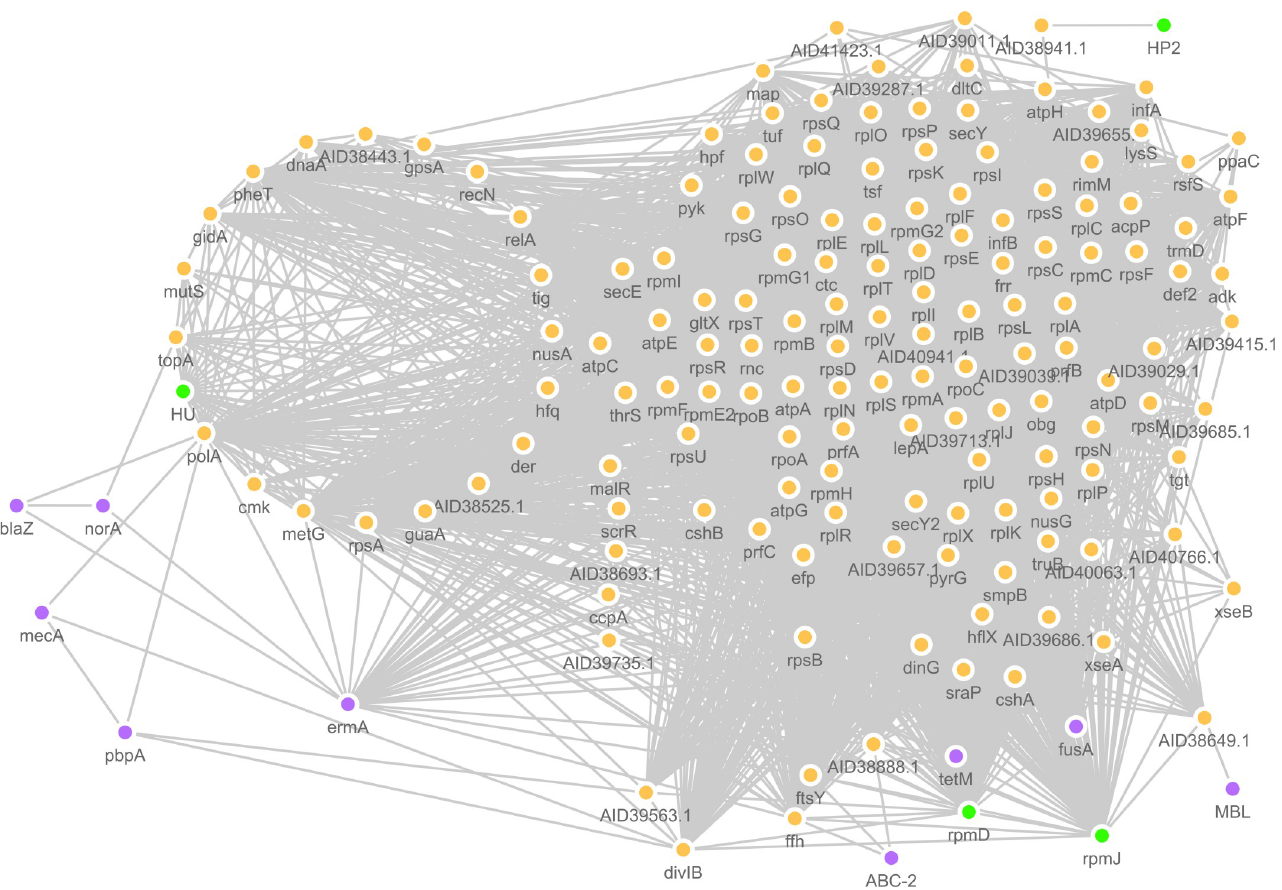
Fig 6. Protein-protein interaction network of the proteins found to correspond to the MALDI-TOF spectral peaks recognized as discriminant between benzylpenicillin resistant and susceptible isolates. The PPI network showing the four discriminant proteins, green circles, (RpmJ, RpmD, HU and hypothetical protein 2 (HP2)) and their first neighbour interactors (orange colours). Amongst these first shell interacting partners, purple nodes represent the antibiotic- resistant proteins (BlaZ, NorA, MecA, PbpA, ErmA, ABC-2, TetM, FusA and MBL) predicted by ResFinder v3.1